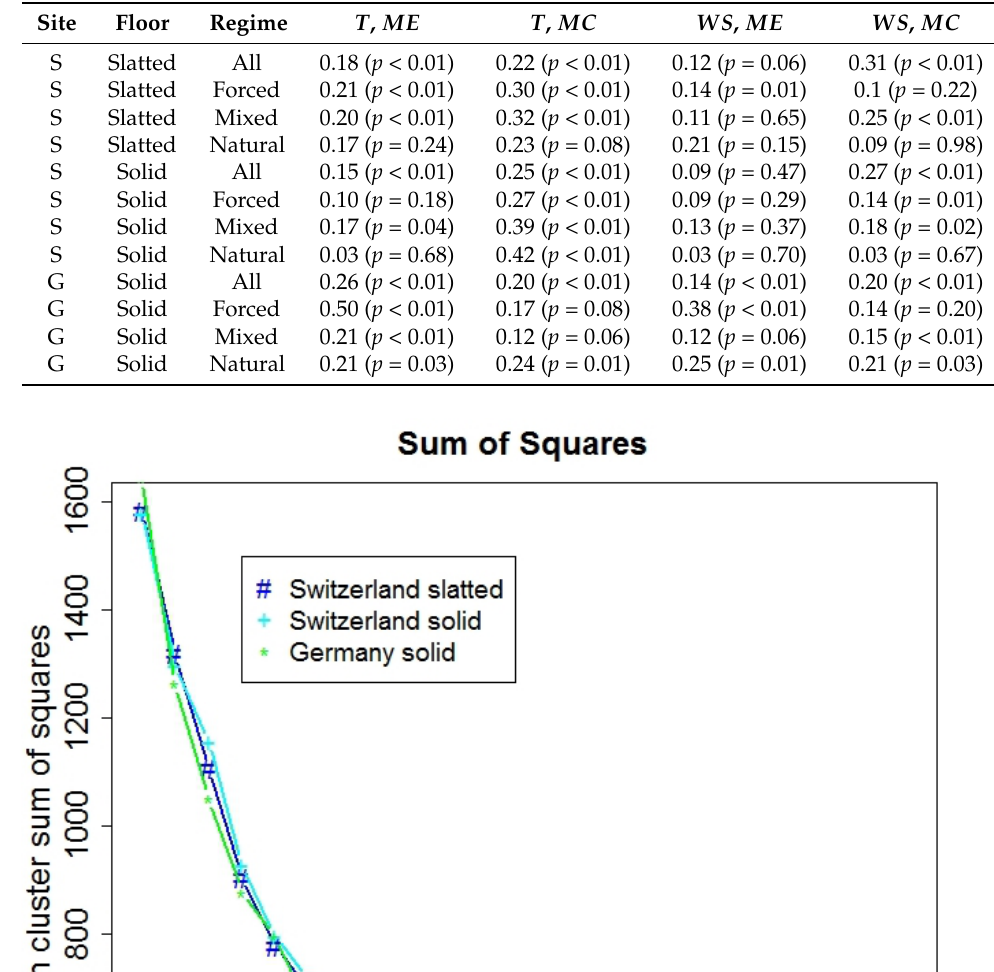
Table 6. Mutual information between air temperature ( T ), wind speed ( WS ), CH 4 emission ( ME ) and CH 4 concentration ( MC ). For each site and flooring system, the statistical association was calculated based on all data as well as based on subsets associated with forced, mixed and natural convection. p -values indicate the exceedance probability of normally distributed random variable sets (see Section 2.4.3).